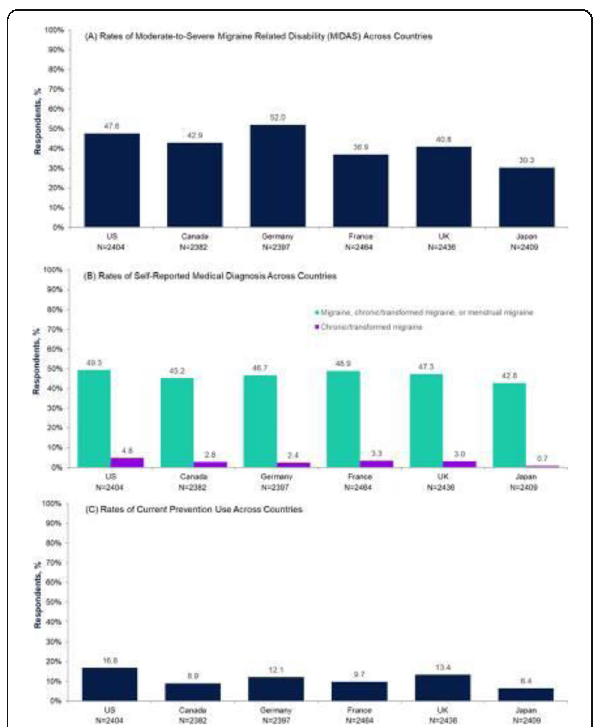
Fig. 1 (abstract P118). Rates of Moderate-to-Severe Migraine- Related Disability (A), Self-Reported Medical Diagnosis (B), and Current Prevention Use (C) Across Countries in CaMEO-I Respondents With